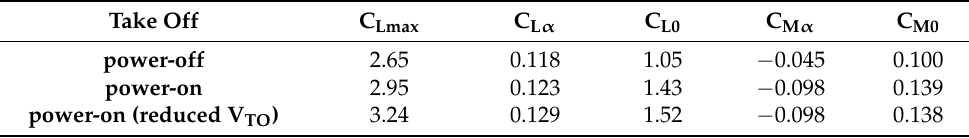
( b ) Figure 25. Drag and pitching moment curves, take-off condition V TO = 44 m/s and V TO = 51 m/s, Re = 5.7 × 10 6 , J TIP = 0.78, rpm TIP = 1600, J DEP = 0.89, rpm DEP = 2000. ( a ) Drag polar (drag expressed in counts). ( b ) Pitching moment coefficient w.r.t. CG pos. (31% mac). Table 17. Numerical results for take-off power-on condition, untrimmed maximum lift coefficient, moment coefficient calculated w.r.t. CG pos. (31% mac), V TO = 44 m/s and V TO = 51 m/s, Re = 5.7 × 10 6 , J TIP = 0.78, rpm TIP = 1600, J DEP = 0.89, rpm DEP = 2000. Take Off